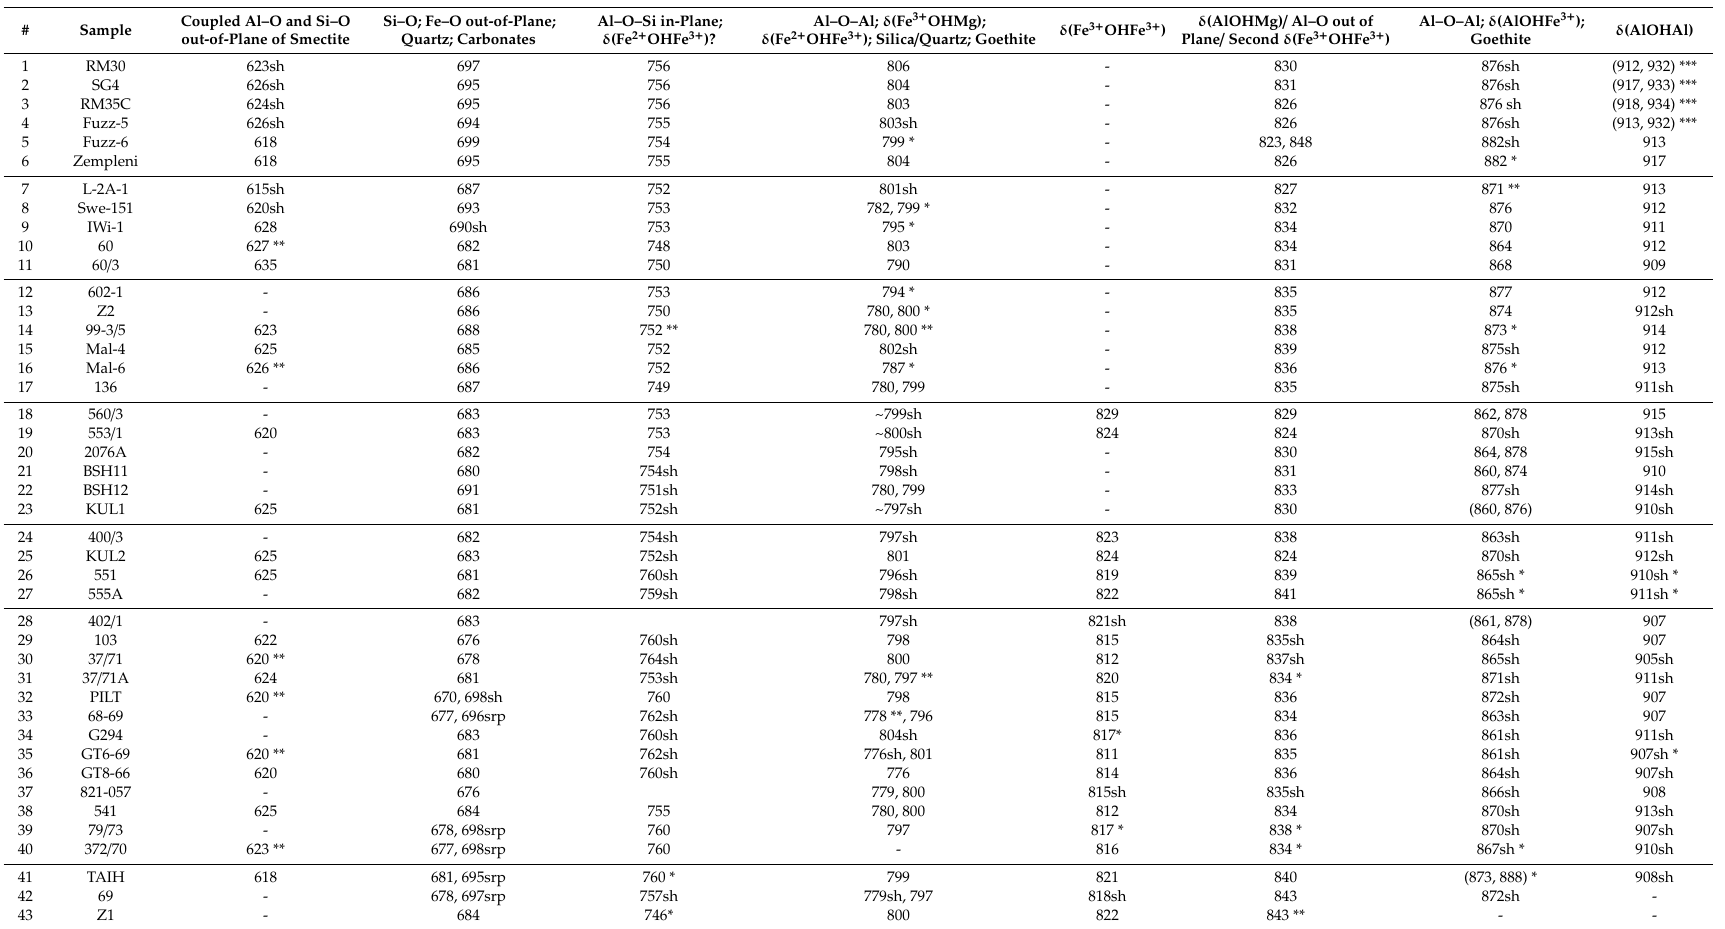
Table 4. Positions (cm − 1 ) of absorption bands of the mica structure and common admixtures in the 950–600 cm − 1